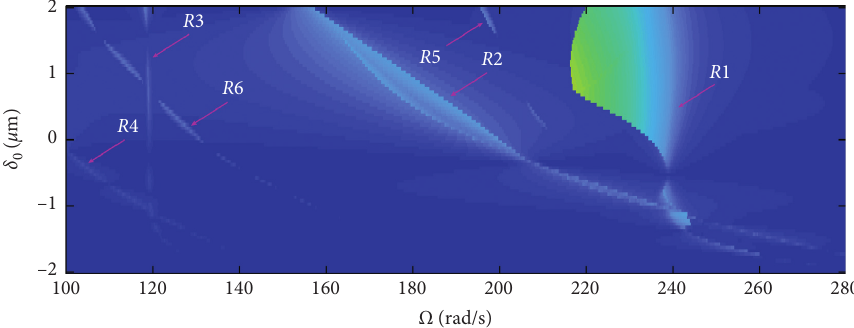
Figure 14: Power spectra of response amplitude for c �